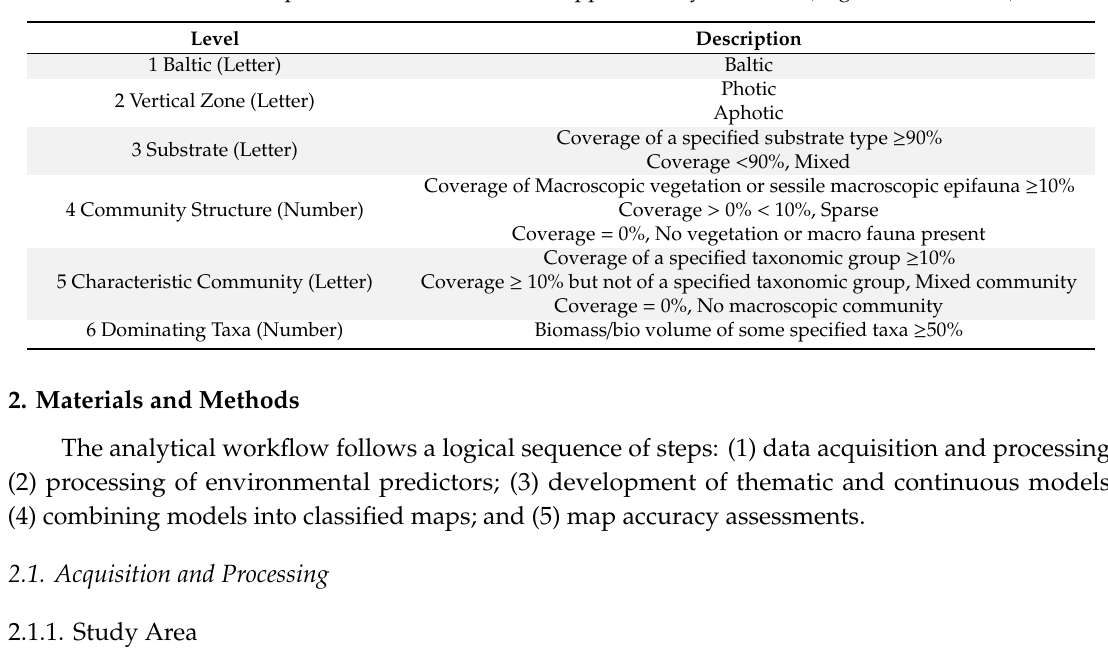
Table 1. The Baltic Marine Environment Protection Commission Underwater Biotope and Habitat Classification System [6] (HELCOM HUB, hereafter referred to as HUB) split rule summary. Examples of HUB level 1–6 biotopes are found in the in the Supplementary Materials (Legend S1, Table